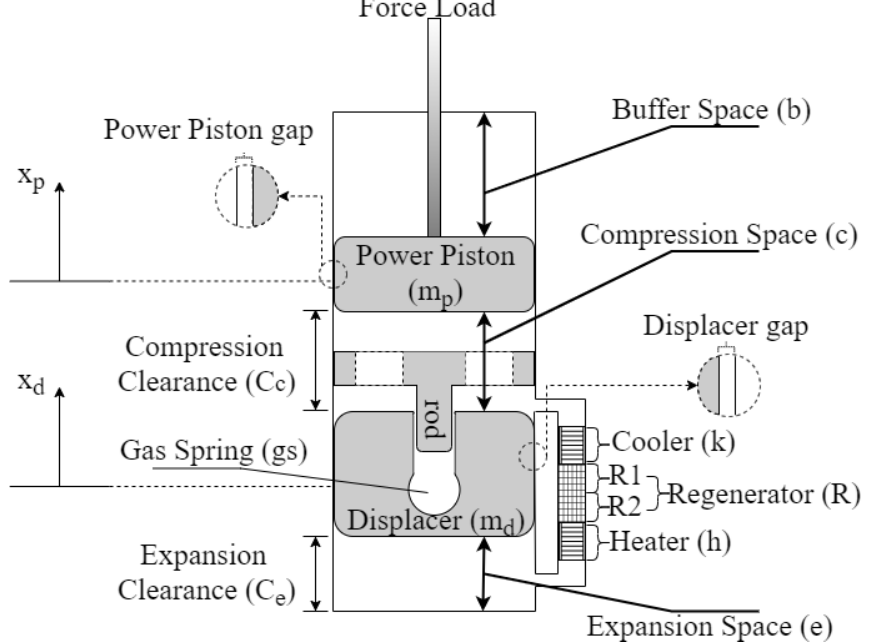
Figure 1. Mechanical schematic of the Free Piston Stirling Engine (FPSE).